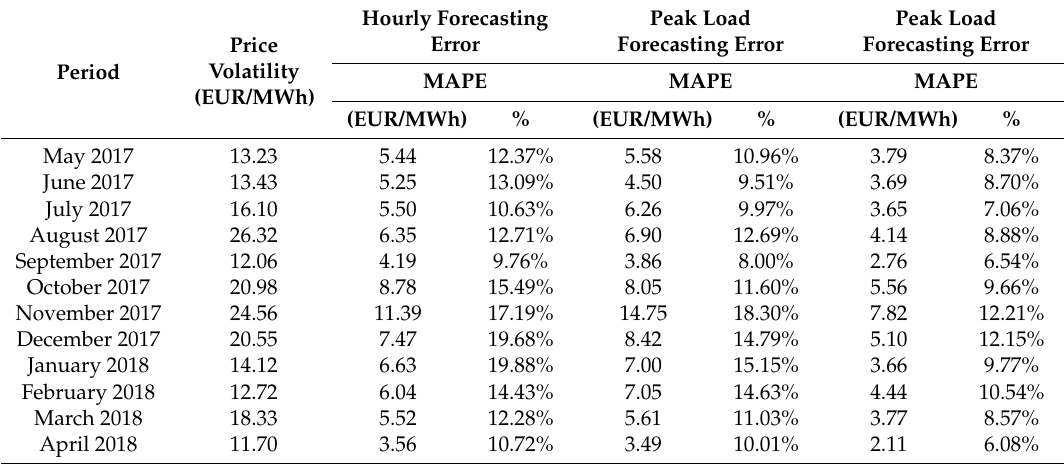
Table 3. Simulation results for electricity price forecast calculated with similar day method in 1 st forecasting interval.